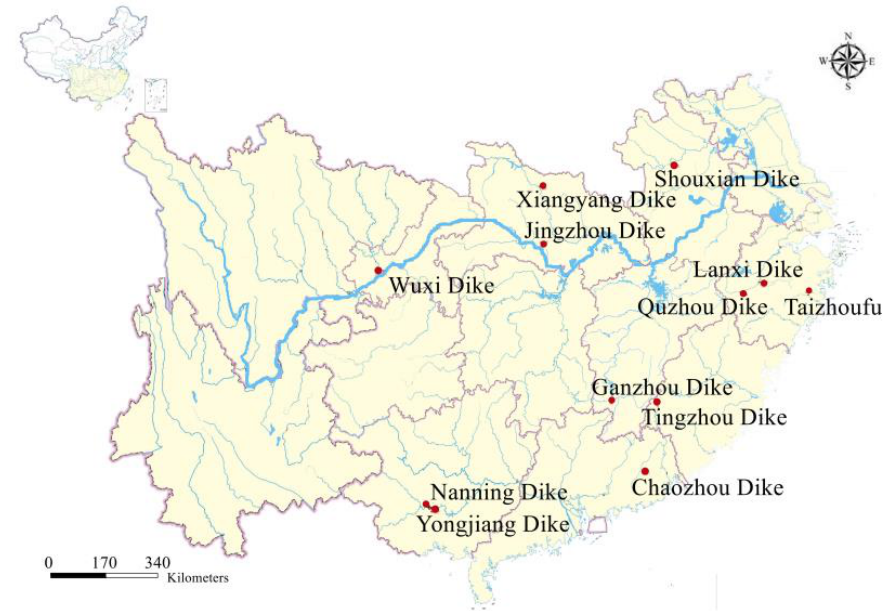
Figure 1. Distribution of typical ancient riverbanks in southern China.